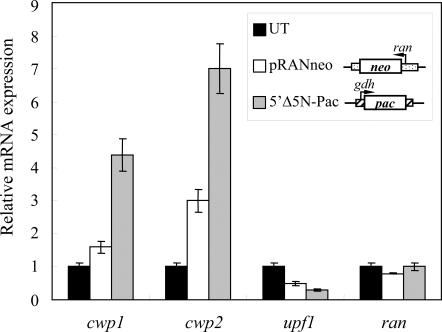
Reverse correlation between the expression levels of the cwp1/2 and upf1 mRNA in stable cell lines.Diagrams of the pRANneo and 5′Δ5N-Pac plasmids for stable transfection are shown in inset. The neo or pac gene (open box) is under the control of the 5′- and 3′-flanking regions of the ran (dotted box) or gdh gene (striated box). Total RNA blots made from vegetative untransfected cells (UT), pRANneo or 5′Δ5N-Pac transfectants were hybridized with specific probes as indicated. Hybridization signals were imaged and quantified as indicated in Materials and Methods. The results are expressed as relative expression level over untransfected control. Values are shown as mean±standard error.